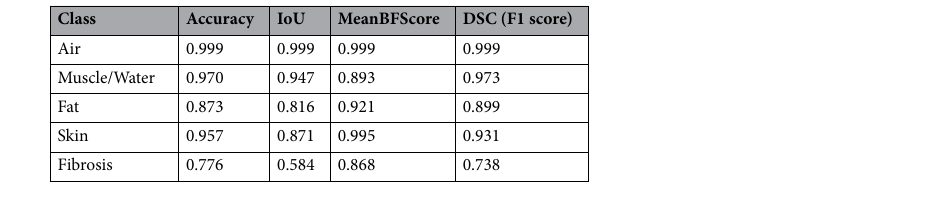
Table 2. Segmentation performance of the trained